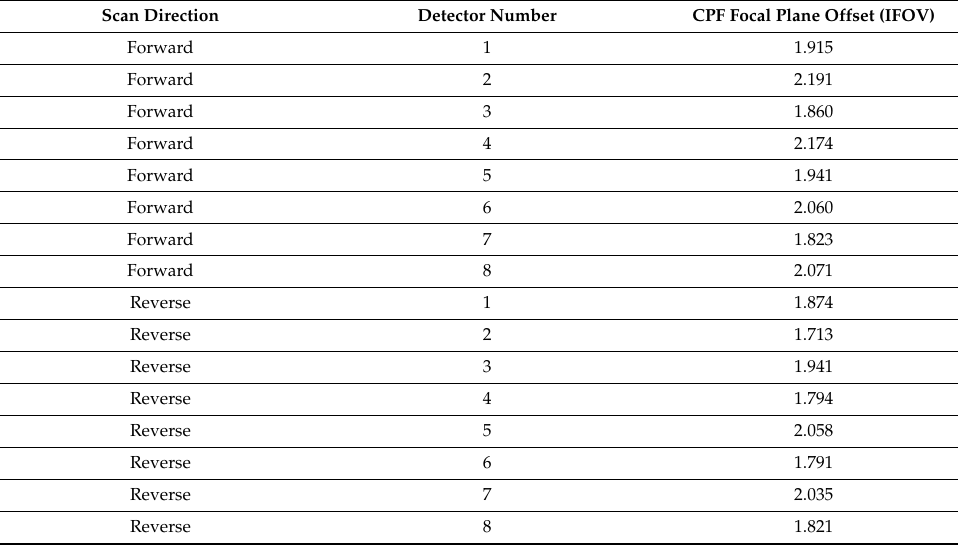
Table 2. Thermal band detector locations post-calibration. These values would be placed within the calibration parameter file to be used for product